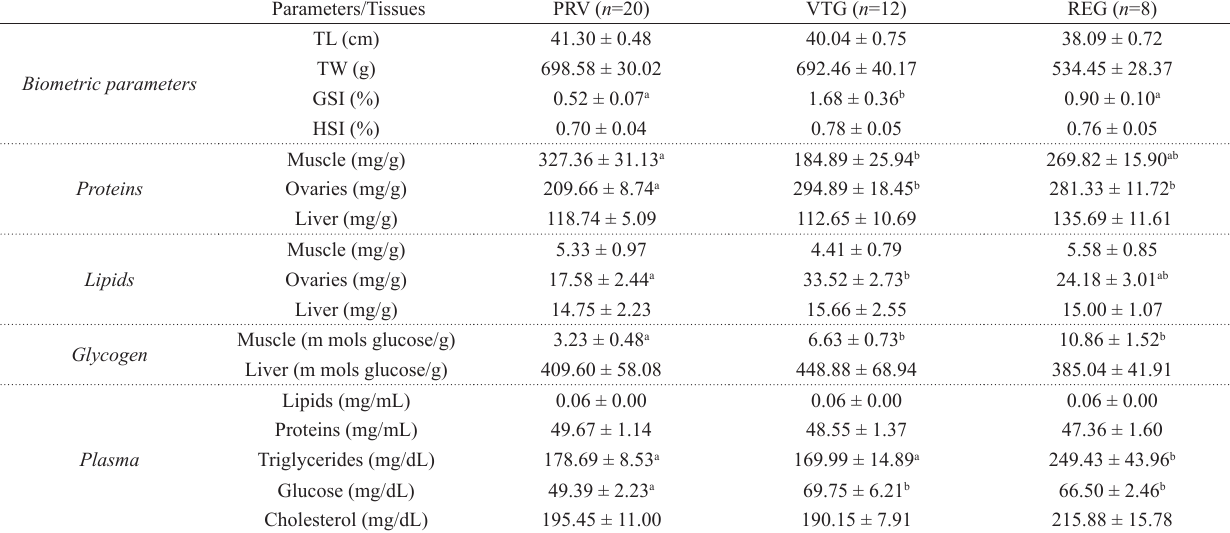
Tab 1. Steindachneridion parahybae : Biometrical parameters (total length and total body mass); hepatosomatic (HSI) and gonadosomatic (GSI) index; tissues and plasma energetic substrate levels during annual reproductive cycle (PRV: previtellogenic; VTG: vitellogenic; and REG: regression stages). Data are presented as the mean ± standard error of the mean. n total number of individuals analyzed; TL - total length; TW - total body mass; GSI - gonadosomatic index; HSI - Hepatosomatic index. ab Statistical difference among reproductive stages ( P < 0.05 ).